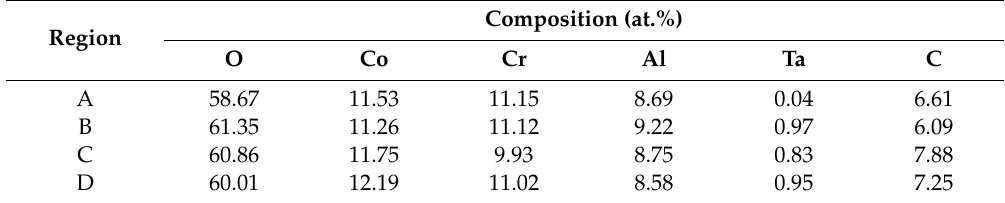
Table 1. Chemical composition of the worn regions of the CoCrAlYTa-10%Al 2 O 3 coatings. Composition (at.%) Region O Co